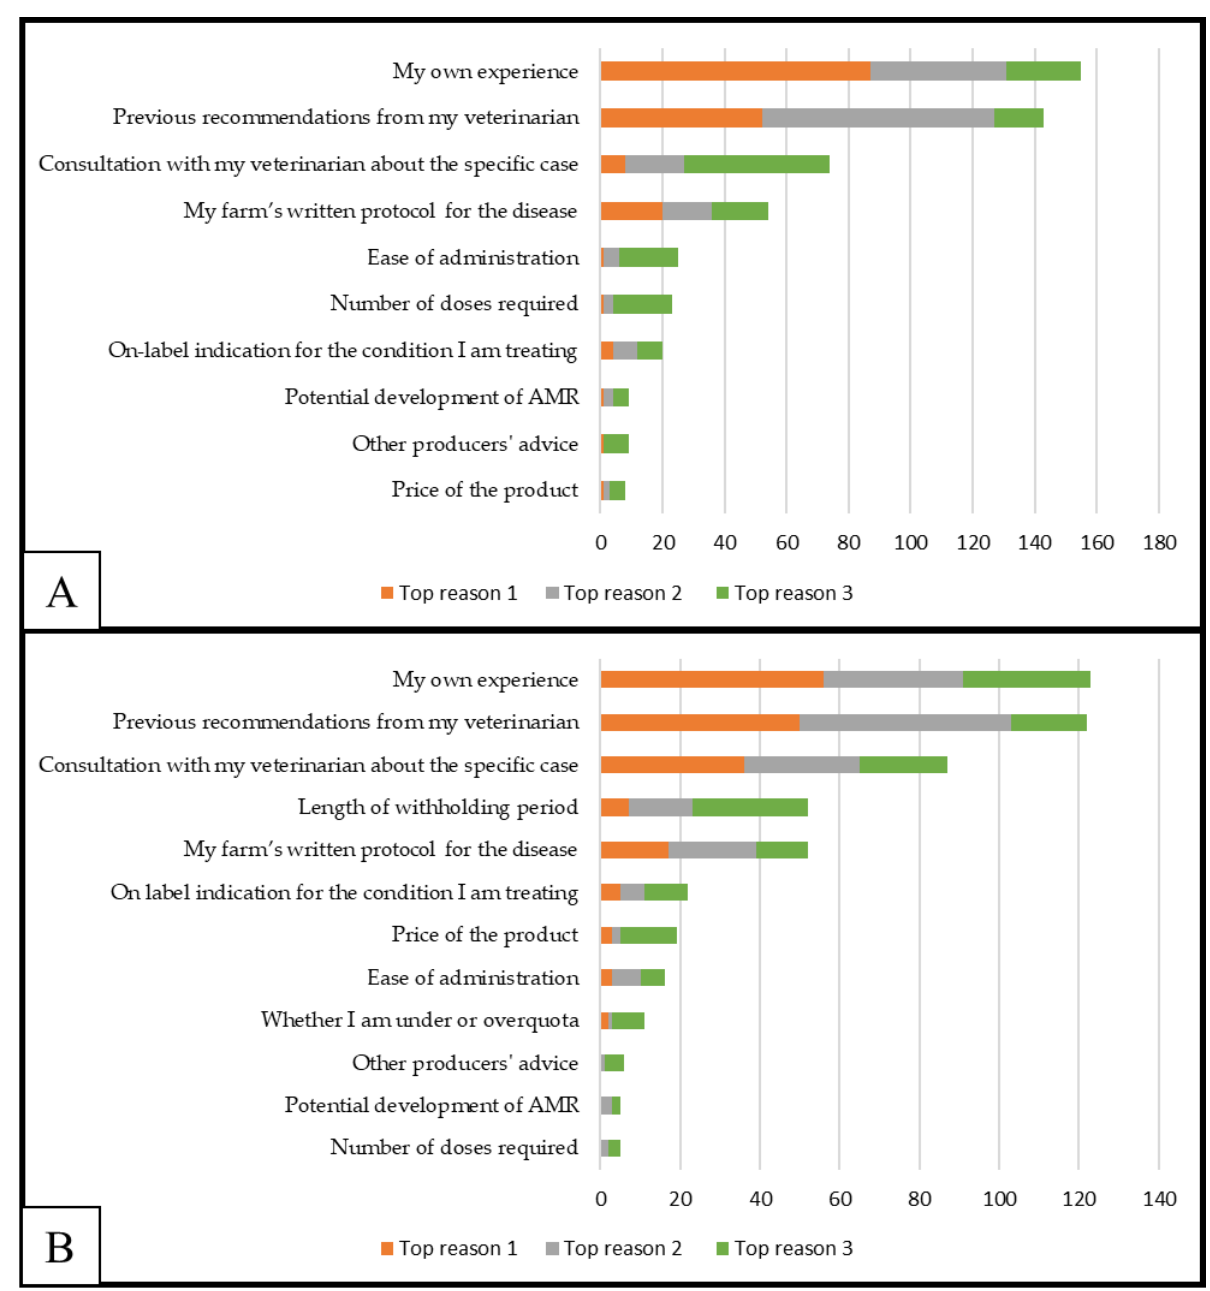
Figure 1. Three most important reasons ranked by 193 dairy farmers when selecting a particular antimicrobial product to treat calves ( A ) or lactating cows ( B ) .